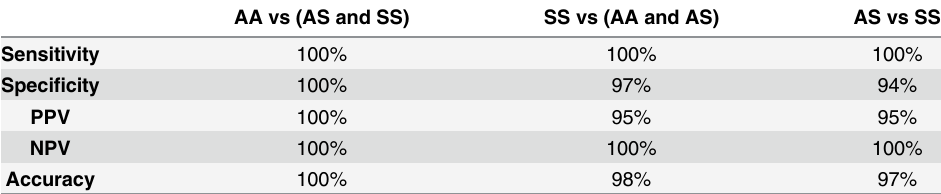
Table 2. Automated diagnosis performance metrics. AA vs (AS and SS) SS vs (AA and AS) AS vs SS Sensitivity 100% 100% 100% Speci fi city 100% 97% 94% PPV 100% NPV Accuracy 100% Summary of performance metrics for automated diagnoses made by the image analysis algorithm on blood samples obtained from healthy subjects and SCD patients in New Orleans,